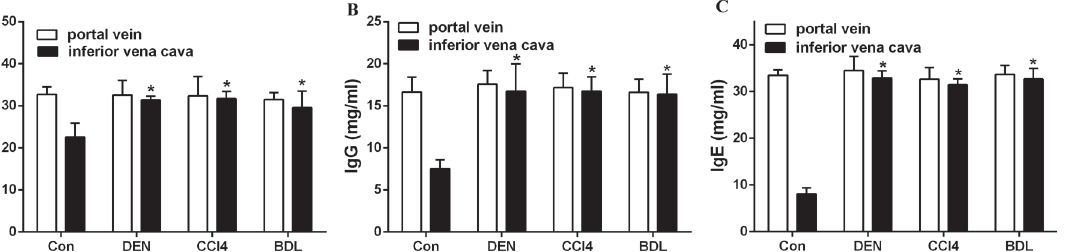
Fig 3. Inferior vena cava serum from rats with injured livers increased the production of immunoglobulin. Total immunoglobulin, IgG and IgE were evaluated in healthy rats that were immunized with serum from the portal vein and inferior vena cava from normal rats and rats treated with DEN, CCl4 and BDL, respectively. * p <